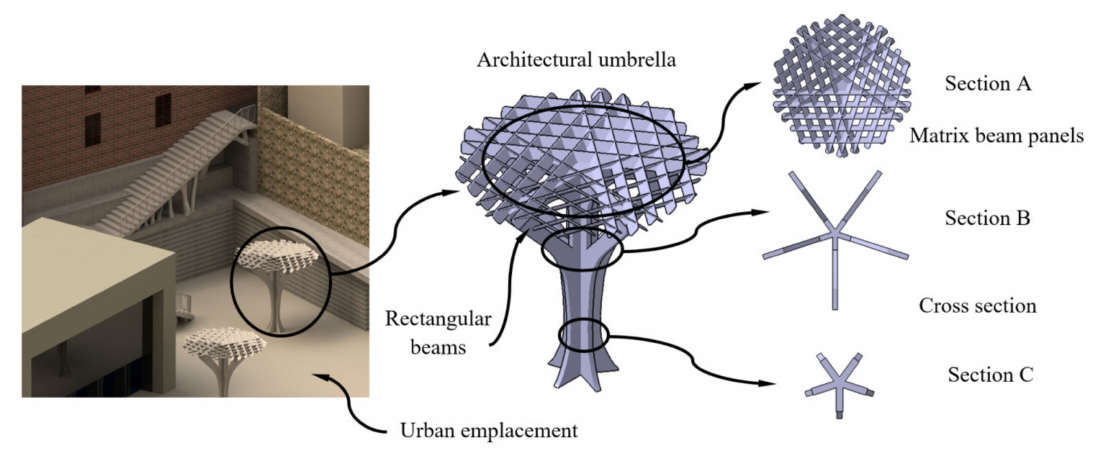
Figure 1. Urban location and topology of the architectural